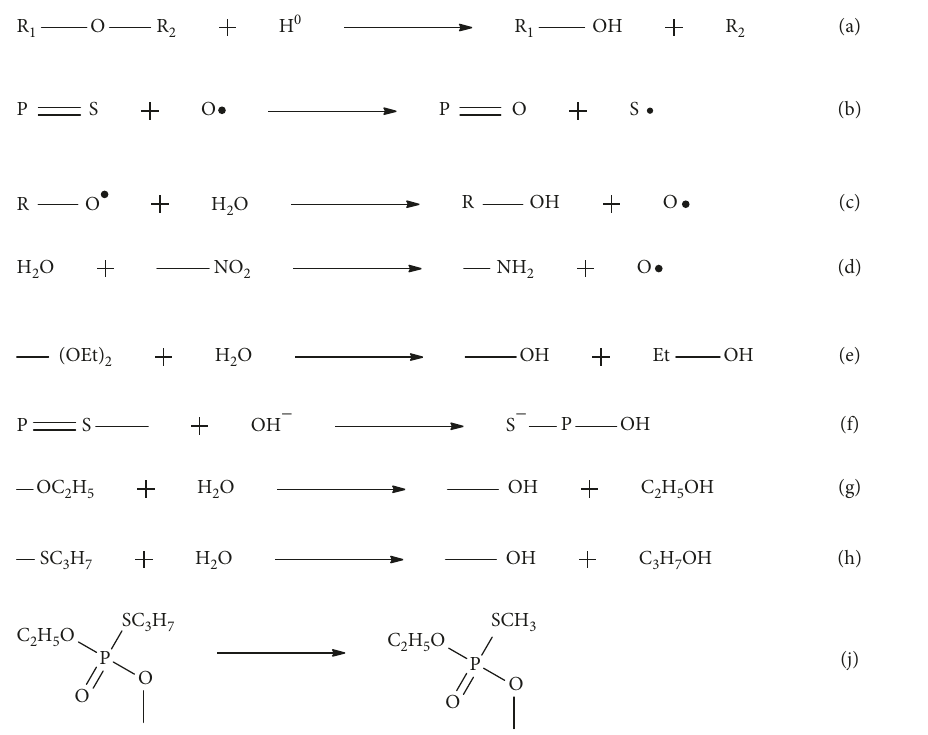
Figure 1: Main photolysis mechanism of